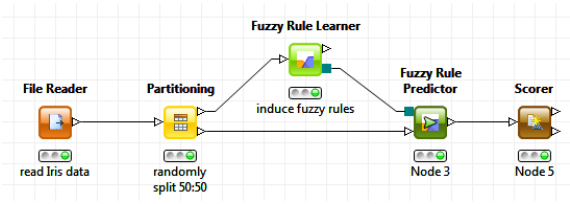
Fig. 1. A small KNIME workflow, which builds and evalu- ates a fuzzy rule set on the Iris